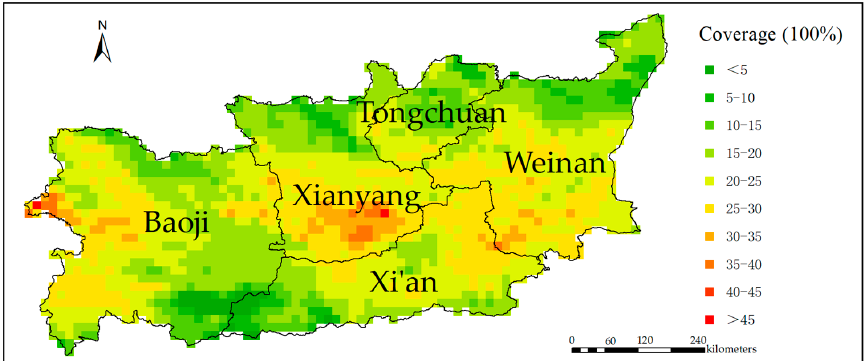
Figure 2. Map showing the spatial coverage of the available Visible Infrared Imaging Radiometer Suite (VIIRS) aerosol optical depth (AOD) with quality assurance (QA) = 3 during the study period